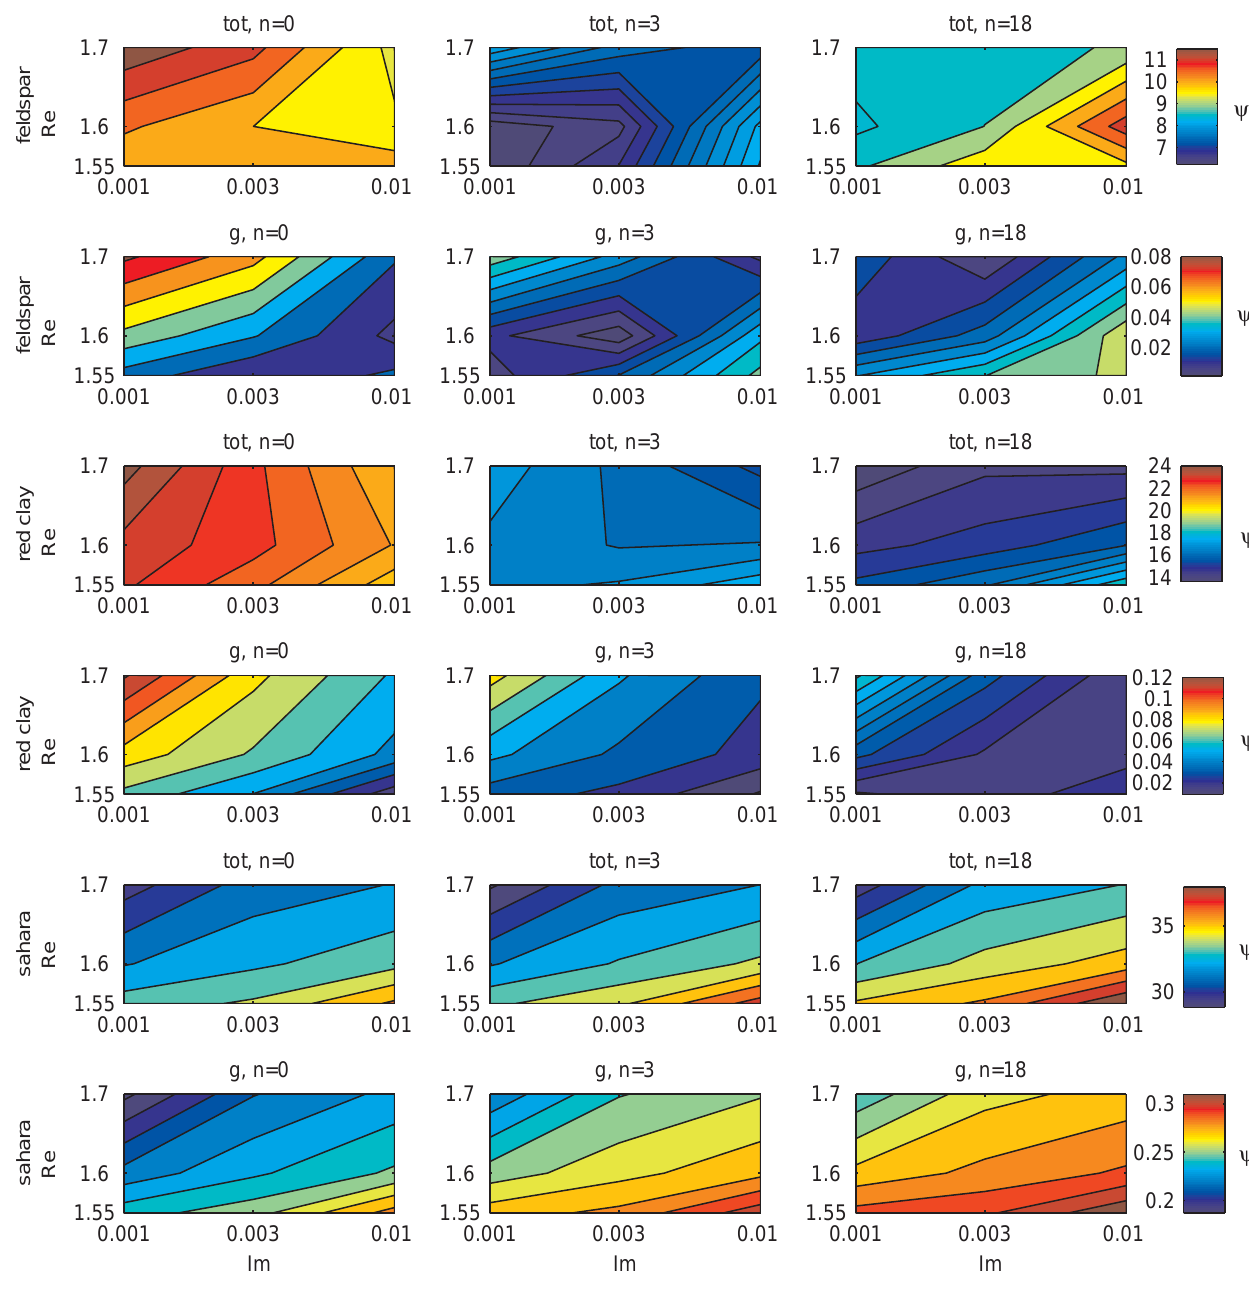
Fig. 5. Cost function dependence on the values of refractive index m . Columns from left to right represent different ξ n distributions, Eq. (6), with n = 0 , 3, and 18, respectively. Small cost function values are shown in blue whilst the worst fit values are shown in red. One should note from the colorbars that the scale varies, values increasing with increasing particle size. Three minerals are represented with 441 . 6 nm, first two rows representing feldspar, then the red clay and last two rows Saharan dust. For each mineral two cost functions are shown on separate rows, namely the average ψ value, Eq. (10), of all scattering-matrix elements (tot.) and that of the asymmetry parameter error ( g ). also on the P 11 element for the shorter wavelength. For to poor performance of spheroids on the Saharan sample, as large errors may mask any subtleties caused by differing re- 632 . 8 nm, the results of loess are not so conclusive as a lower fractive indices. For loess (not shown), the m = 1 . 7 + 0 . 001 i real part and a higher imaginary part of the refractive index provides the best fit on the average of all the elements and are also producing good modelling results for g . Overall,